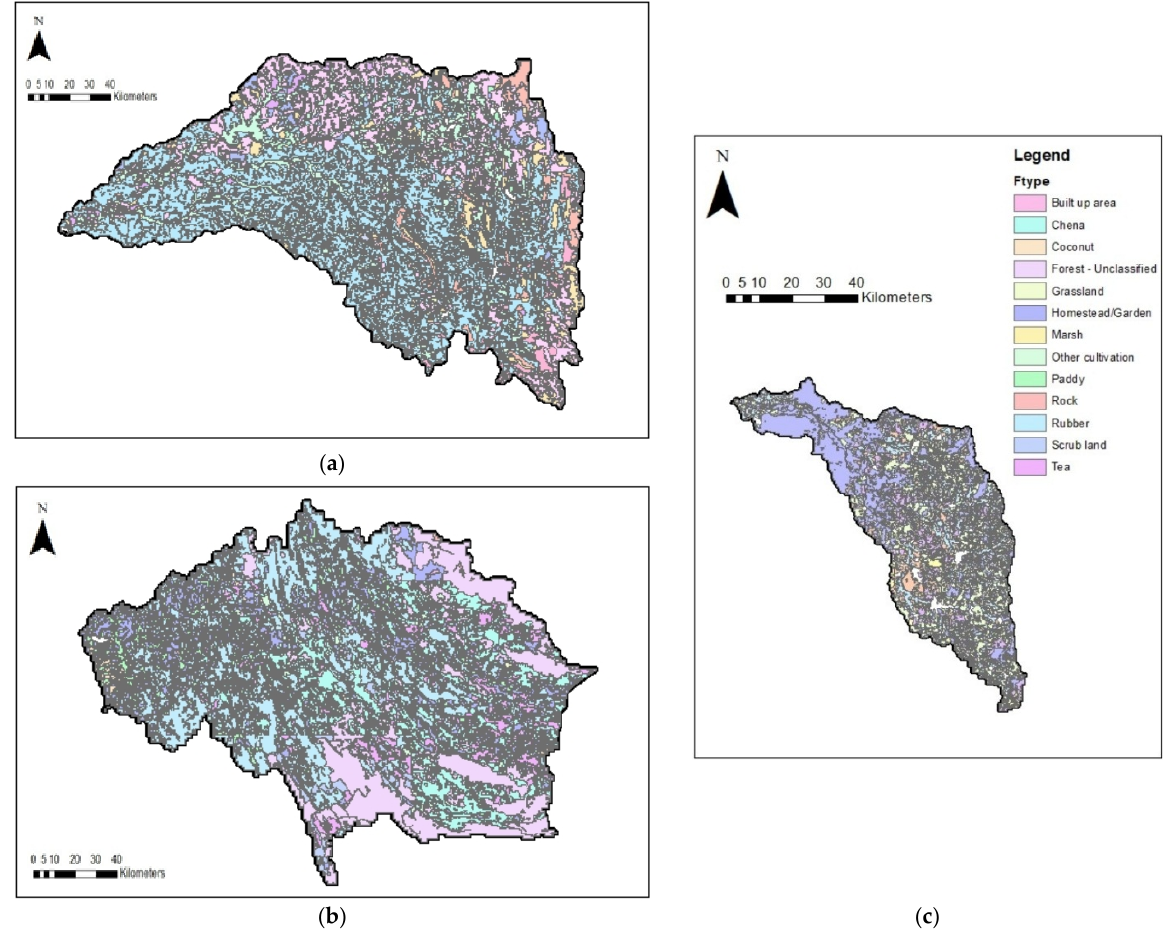
Figure 2. Land use of the three catchments: ( a ) Deduru basin; ( b ) Kalu basin; ( c ) Malwathu basin.